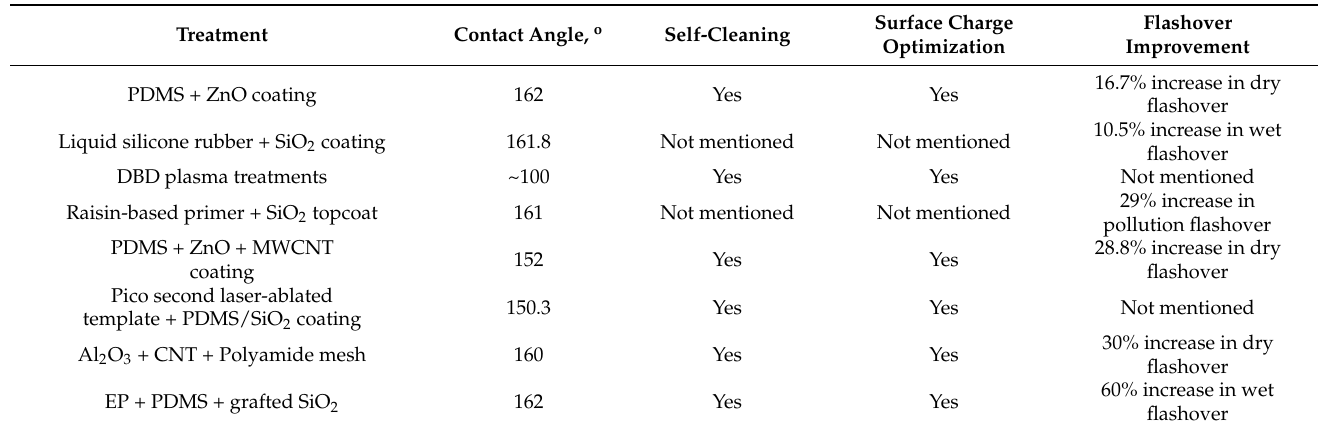
Table 5. Comparison of the various surface treatments